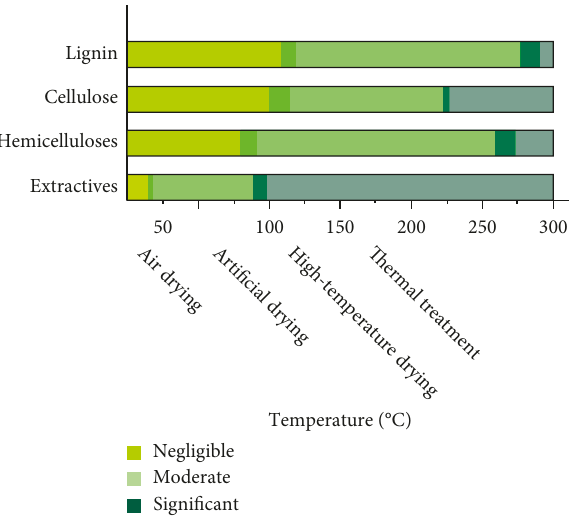
Figure 1: A schematic representation of changes in wood com- ponents with increasing temperature under humid conditions, but without regard to time